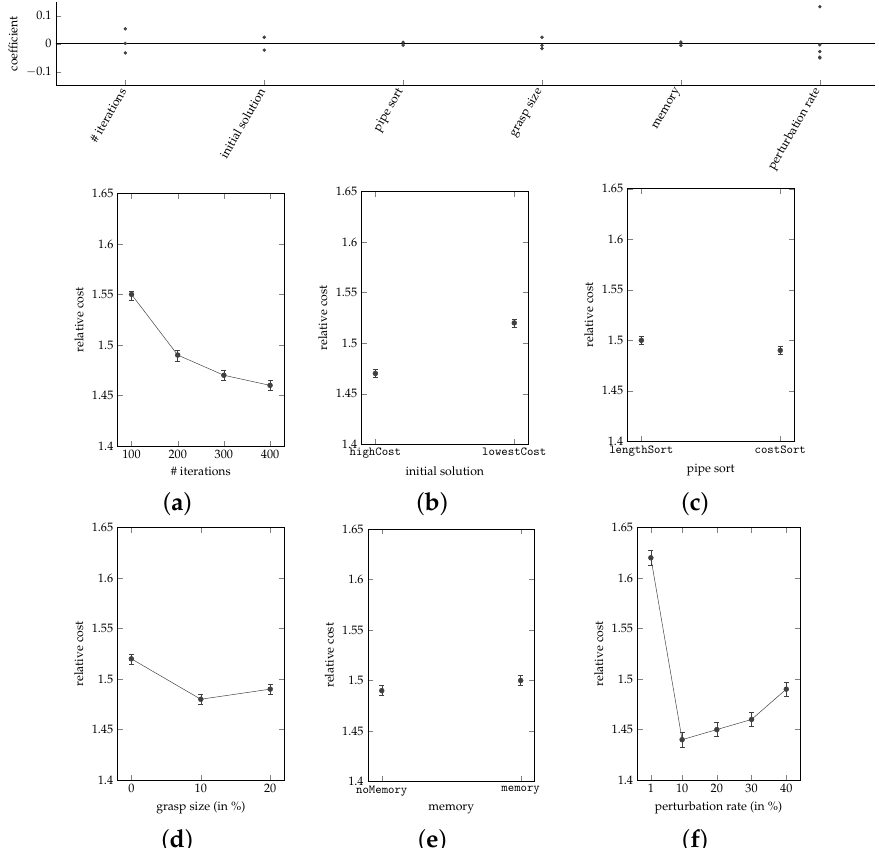
Figure 7. Values of the coefficients and mean plots for the regression model on the relative cost : main